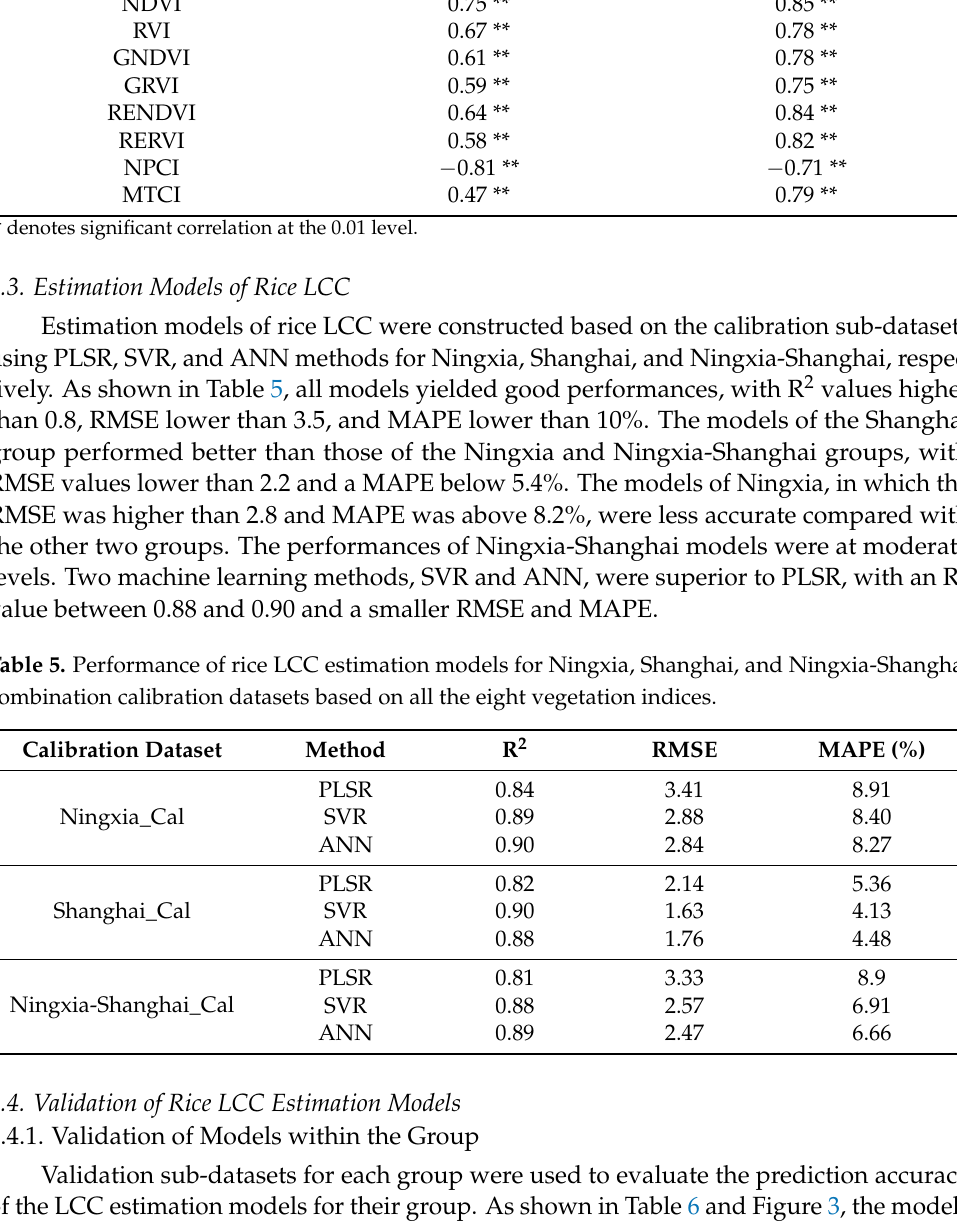
Table 4. Correlation coefficients between vegetation indices and rice LCC in Ningxia and Shanghai. Vegetation Index